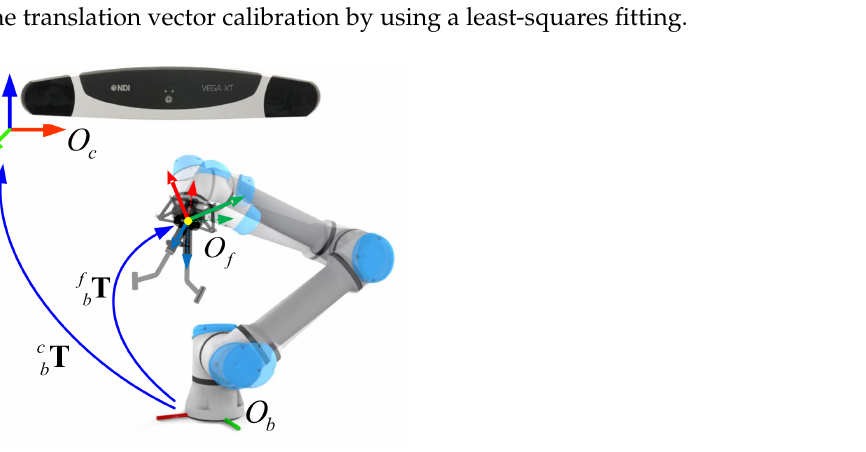
Figure 5. Rotating around the origin of the flange COS. The yellow point indicates the origin of the flange COS. During the rotation, we maintain a fixed relationship between the camera and the robot